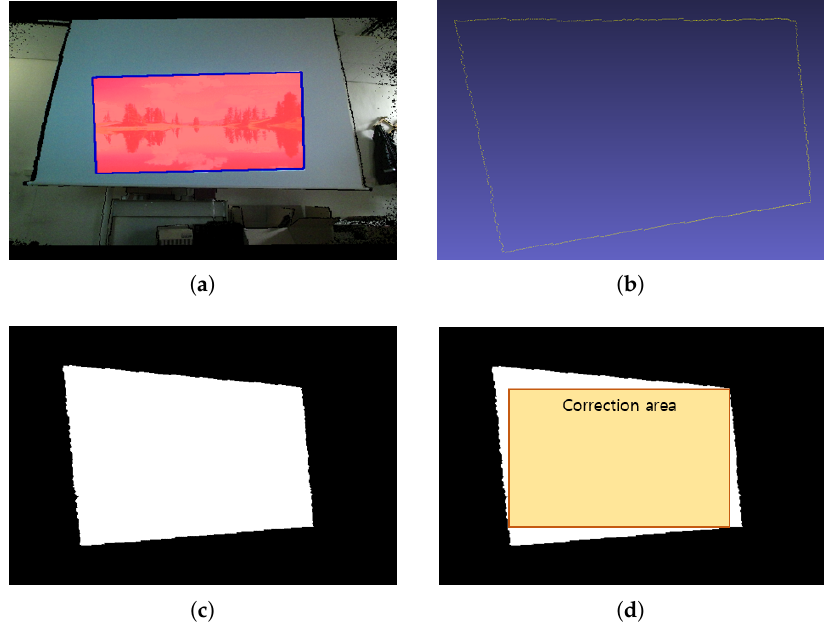
Figure 6. An example of maximum rectangular region detection for the correction area: ( a ) the detected boundary on the projection surface masks depth image M s ( x , y ) ; ( b ) 3D points of the detected boundary at the 3D user coordinates; ( c ) the rasterized image of the projection area; ( d ) the final maximum rectangular region calculated from the correction